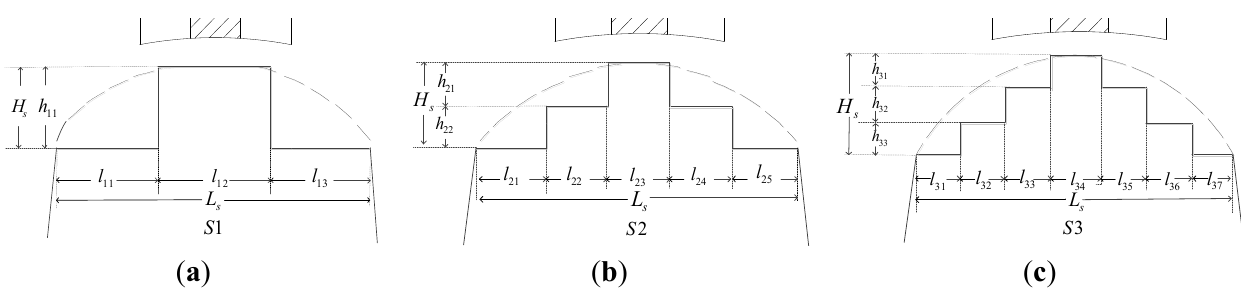
Figure 7. Stepped teeth schemes and design variables: ( a ) S1; ( b ) S2; and ( c ) S3.